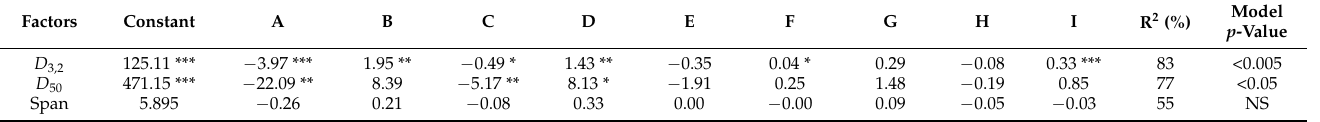
Table 3. Response surface coefficients, coefficient of determination (R 2 ), and significance of